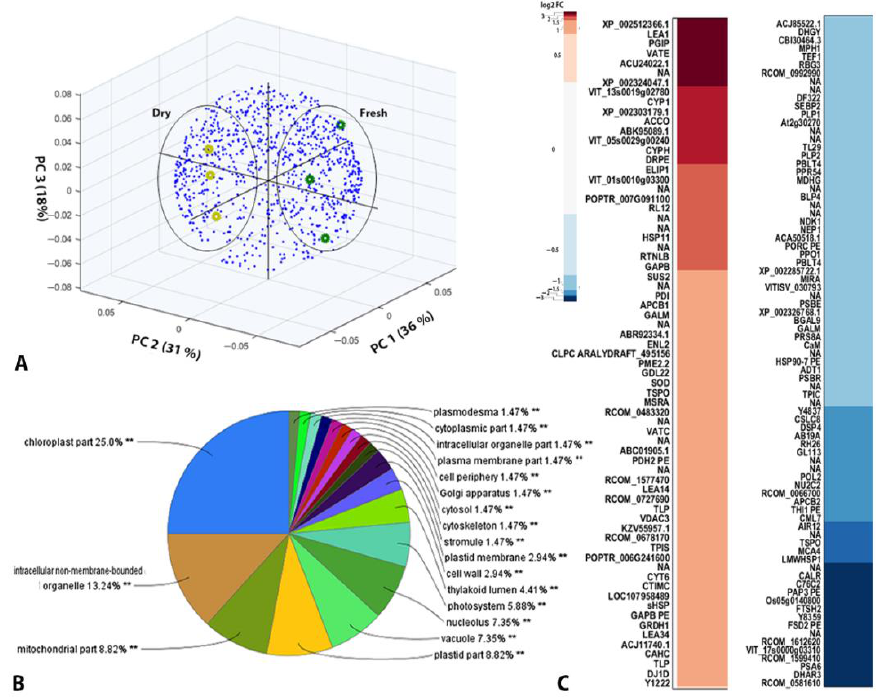
Figure 2. Shotgun proteomics. ( A ) Principal component analysis biplot showing the distribution of proteins (blue dots) from fresh and dry samples (colored circles) along with the first three principal components. ( B ) GO annotation of the subcellular localization of the identified proteins. Statistically significant enriched localization of identified proteins is given by asterisks ( C ) Heat map showing the mean log2 fold change (log2 FC) for the abundance of each identified protein in response to drought stress. Gene annotations are provided for significantly (|log2 FC| > 1) more (red) or less abundant (blue) proteins in dry plants.